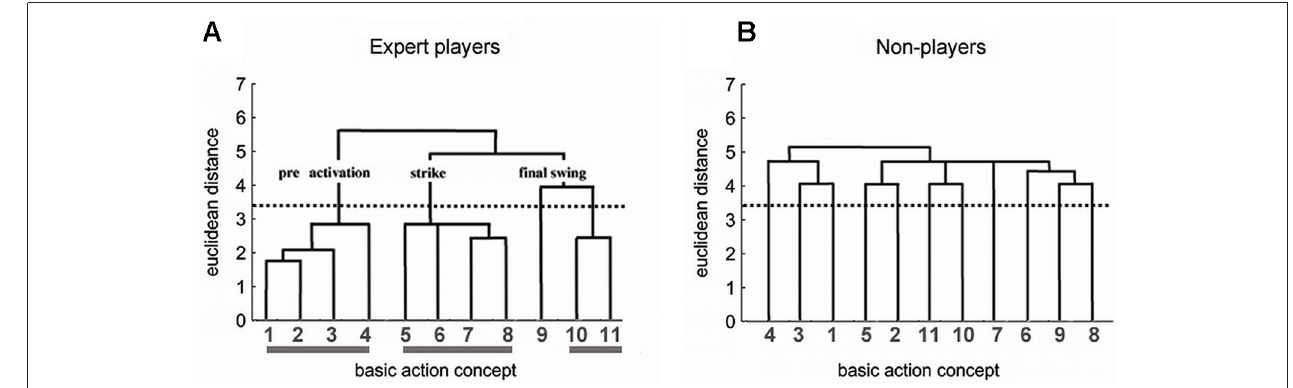
(1) ball throw, (2) forward movement of the pelvis, (3) bending the knees, and (4) bending the elbow. Second, in the strike phase, energy is conveyed to the ball. The following BACs were identified: (5) frontal upper body rotation, (6) racket acceleration, (7) whole body stretch motion, and (8) hitting point. Third, in the final swing phase, the body is prevented from falling, and the racket movement is decelerated after the strike. The following BACs were identified: (9) wrist flap, (10) forward bending of the body, and (11) racket follow